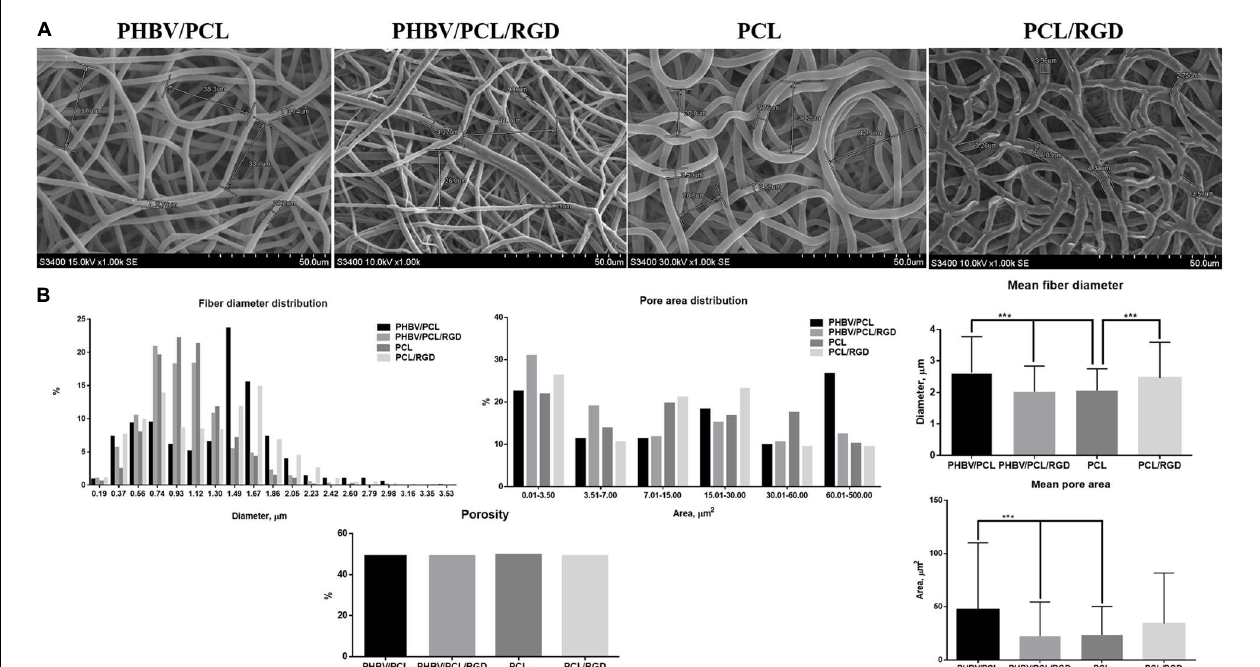
FIGURE 3 | PHBV/PCL and PCL vascular grafts with RGD peptides have a distinct morphology. (A) Scanning electron microscopy images of PHBV/PCL and PCL grafts with and without RGD peptides. (B) Morphological parameters of PHBV/PCL and PCL grafts with and without RGD peptides; quantitative image analysis revealed a higher mean fiber diameter and mean pore area in PHBV/PCL compared to PCL grafts and in PHBV/PCL grafts with RGD peptides compared to those without, data are represented as mean with standard deviation, ∗∗∗ P < 0.001, two-tailed Student’s t -test.